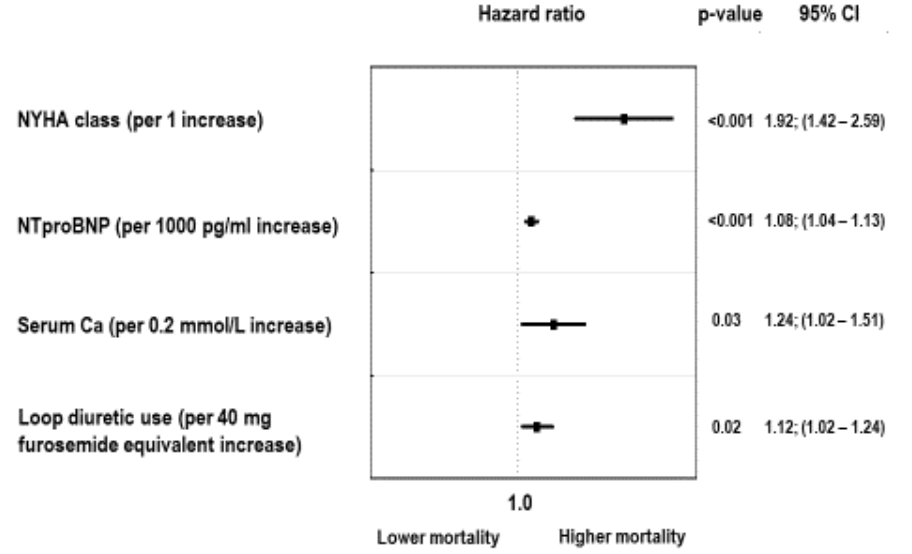
Figure 6. Independent predictors of all-cause mortality in fully adjusted model.